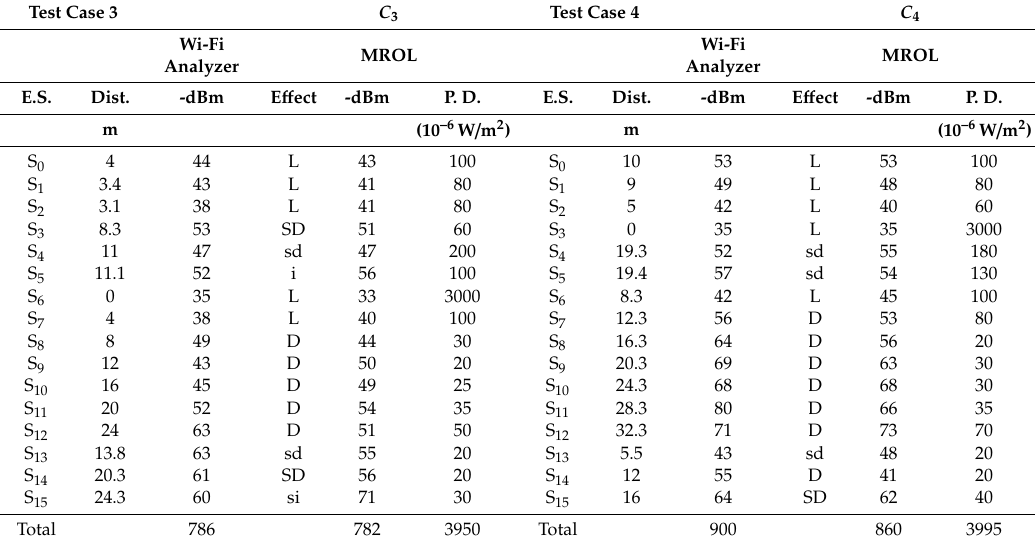
Table 3. Comparison of electromagnetic wave signal strength and total electromagnetic wave power density for S 0 , S 1 , ... , and S 15 to C 3 and C 4 . Test Case 3 Figure 14. C 3 , C 4 and 16-embedded-system layout.